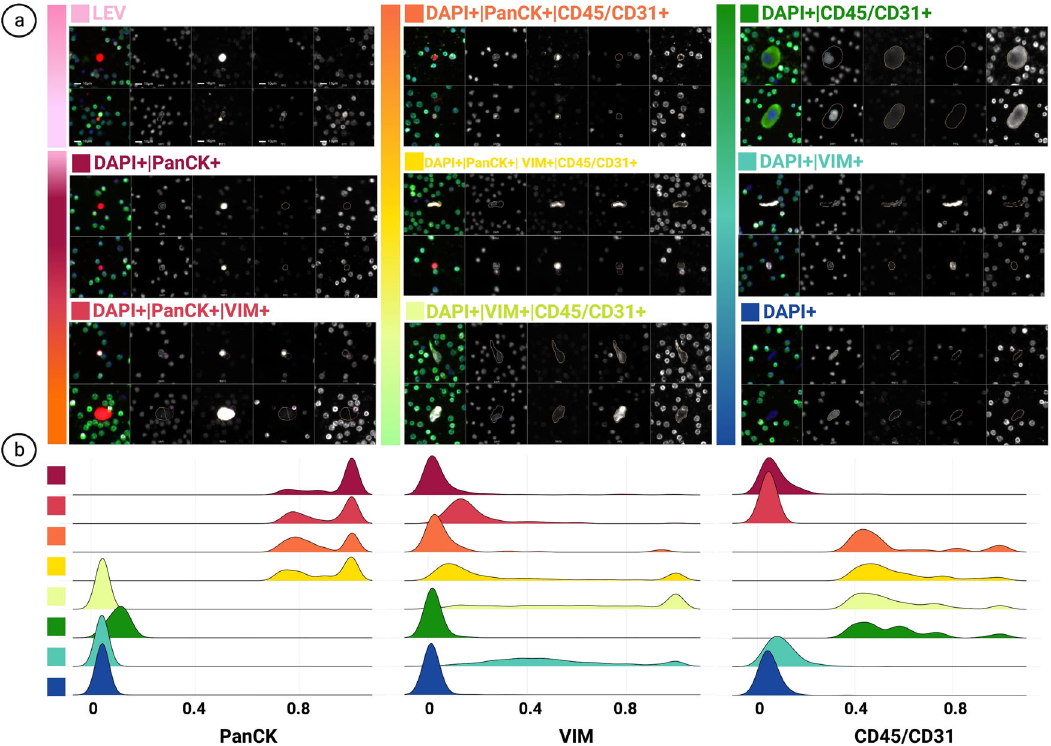
Fig. 1 HDSCA3.0 Rare Event Gallery. a Images represent two candidate rare events, categorized by marker expression. b Signal distribution of immuno fl uorescent markers for channel-classi fi ed cells. Designated colors represent each channel-classi fi ed group, assigned in a . (LEVs not included due to variation in segmentation). Scale bar represent 10 μ